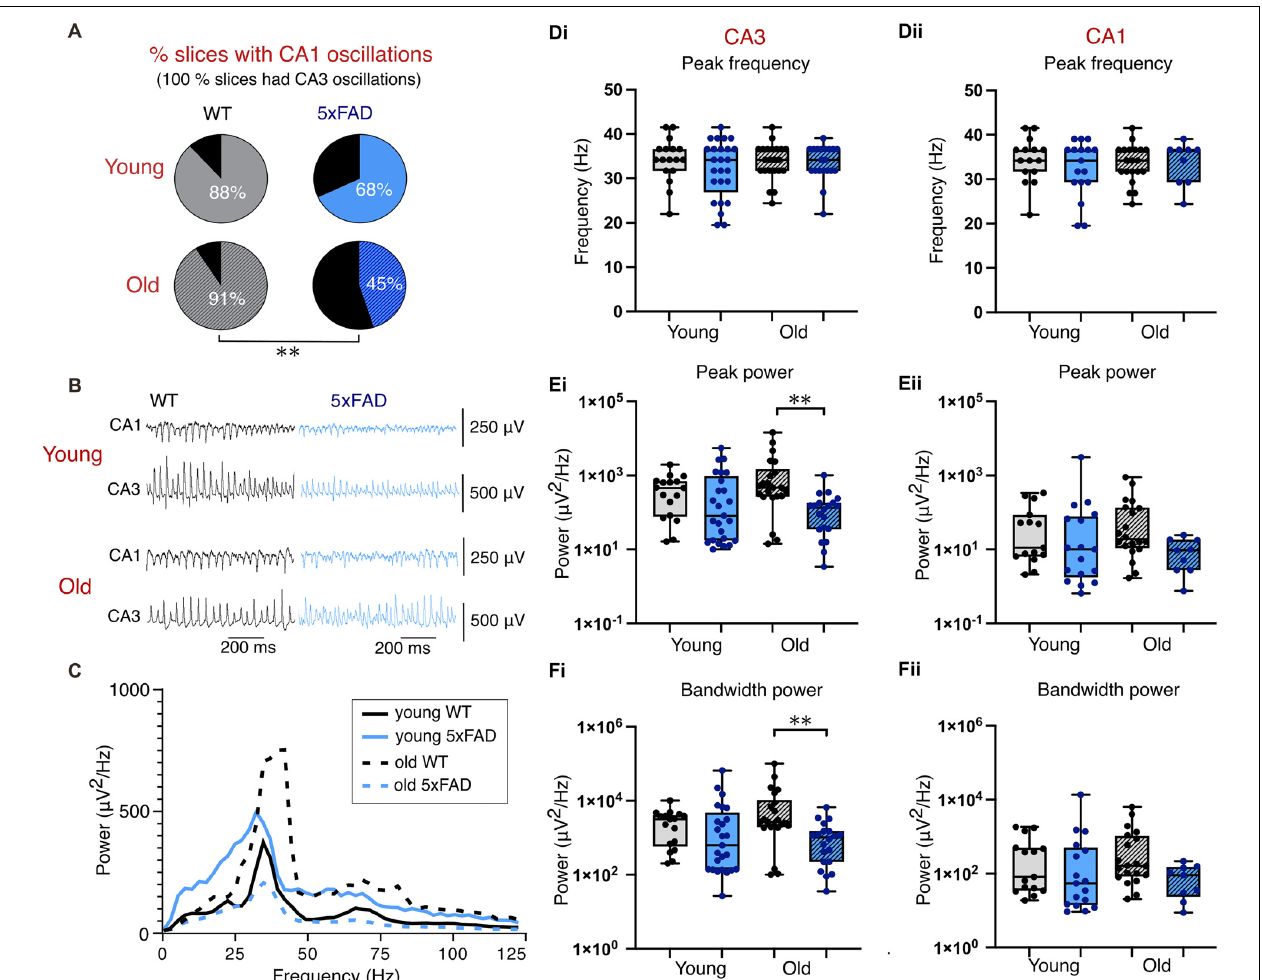
FIGURE 4 | Kainate-induced gamma oscillations. (A) Pie charts indicating the percentage of slices with coincident CA1 and CA3 oscillations (all slices included in analysis exhibited CA3 gamma oscillations). (B) Representative traces of kainate-induced gamma oscillations. (C) Average CA3 power spectrums of young and old, control and 5xFAD slices during kainate-induced oscillations. (D,E,F) Group data boxplots of the peak frequency, peak gamma power and bandwidth power, respectively, from young and old control and 5xFAD animals in CA3 (Di,Ei,Fi) and CA1 (Dii,Eii,Fii) . Each data point represents a single slice. Young WT: n = 17/15 (CA3/CA1), eight mice (three female); Young 5xFAD : n = 25/17 (CA3/CA1), eight mice (four females); old WT: n = 22/20 (CA3/CA1), eight animals (three females); old 5xFAD : n = 20/9 (CA3/CA1), seven mice (three females). ∗∗ p < 0.01 ( A : χ 2 test; D , E , F : two-way ANOVA with Sˇ idák correction for multiple